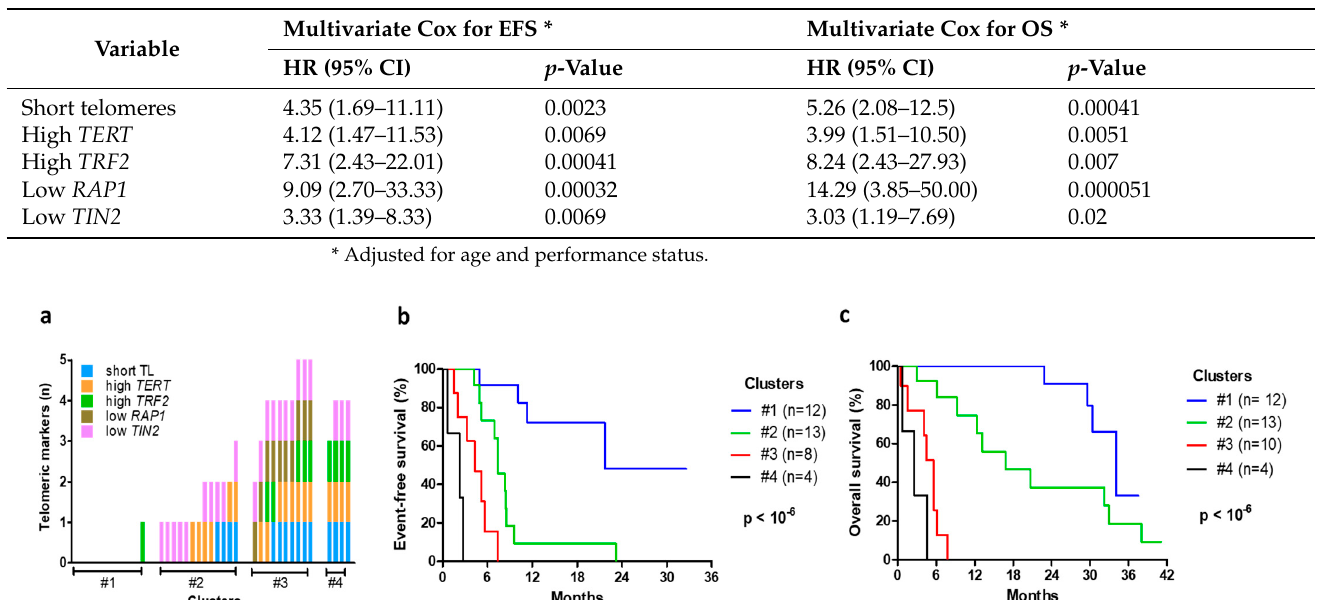
Table 3. Multivariate analyses for EFS and OS in the advanced NSCLC cohort.